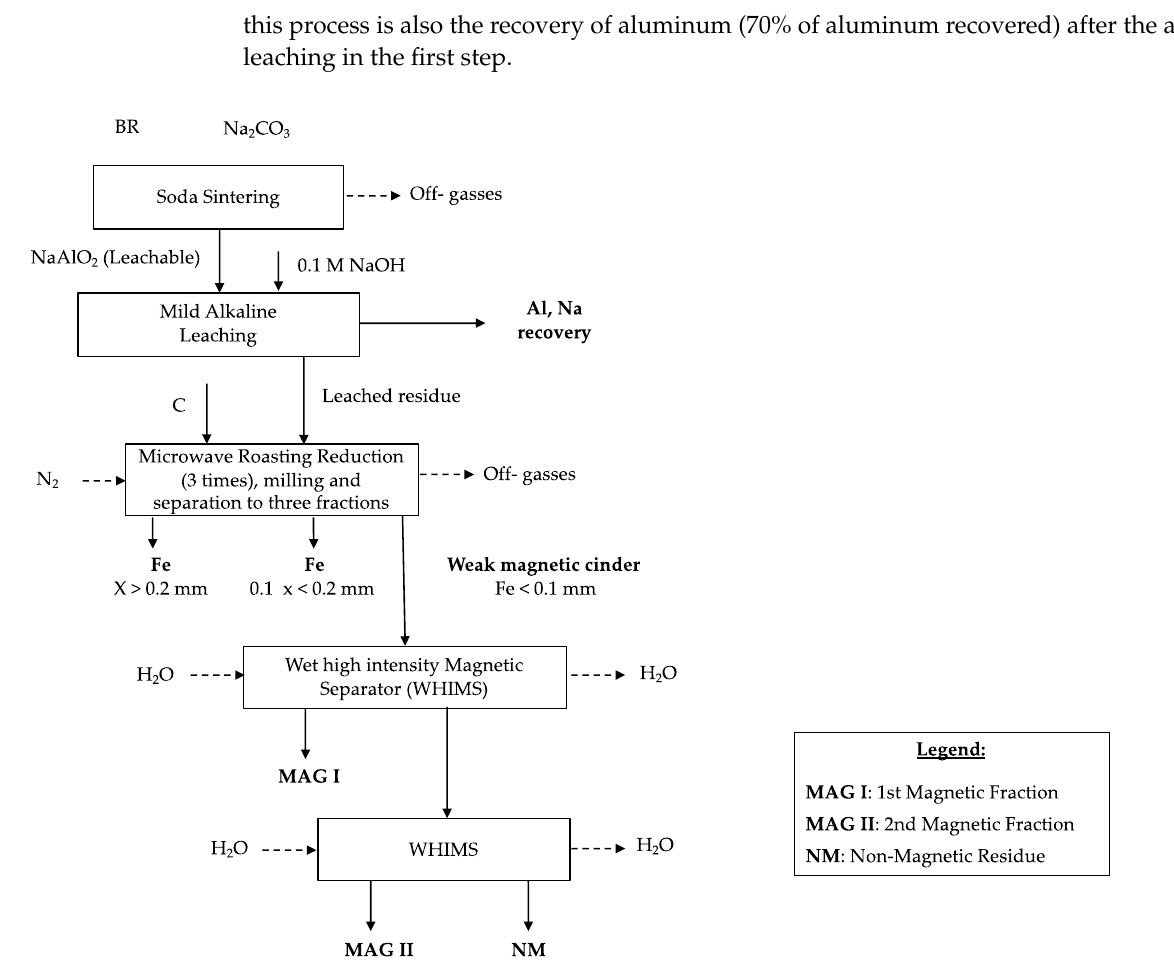
Figure 18. Flowsheet of the combinations of soda sintering and carbothermic microwave roasting processes.